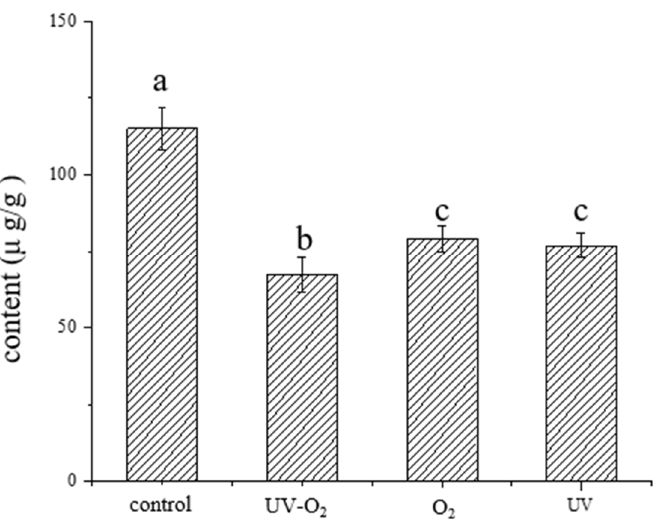
Figure 1. Total content of volatile compounds in fried pepper oil stored for 30 days under different storage conditions. Different letters are significantly different ( p < 0.05). Tukey’s post hoc test ( p < 0.05) was performed to compare samples significantly different. Storage conditions: UV (UV irradiation), O 2 (oxygen exposure), UV–O 2 (UV irradiation- oxygen exposure); control sample (con); day (d).